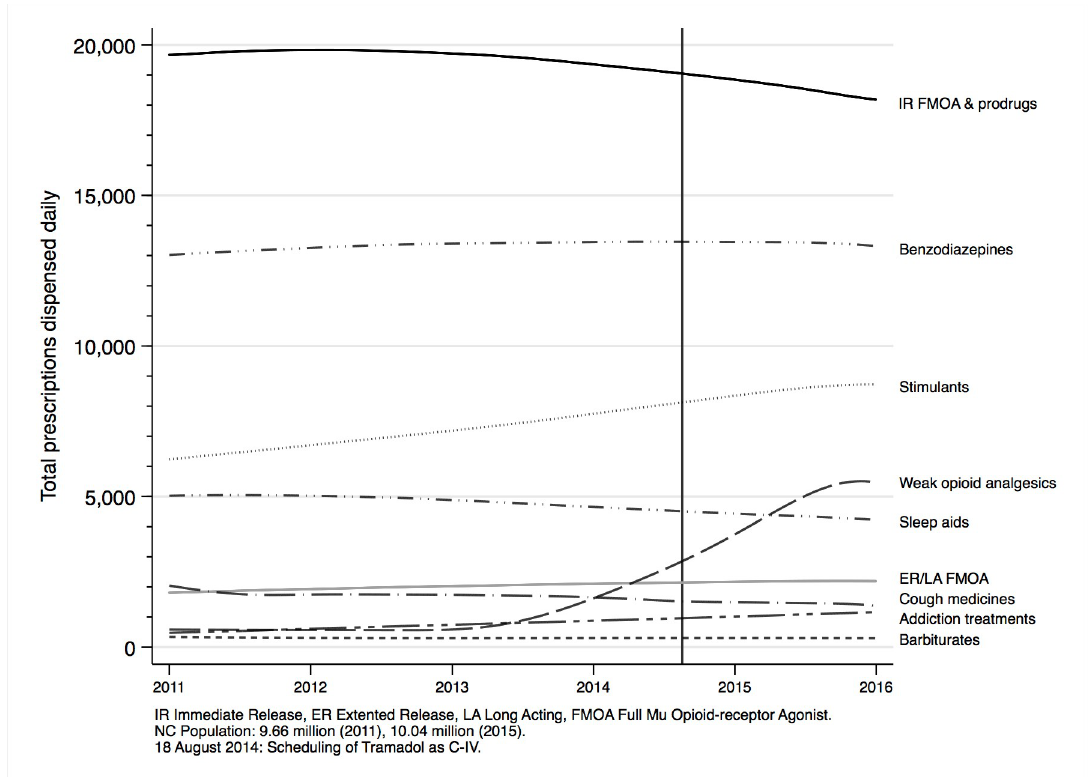
Fig 2. Daily prescribing of controlled substances by class, North Carolina, 2011-2015. During the study period, immediate release full mu opioid receptor agonist and agonist prodrug analgesics accounted for the most controlled substance prescriptions daily. The class of controlled substances with the greatest absolute and relative change was the weak opioid analgesic class. This was due to the scheduling of tramadol as a C-IV controlled substance during the study